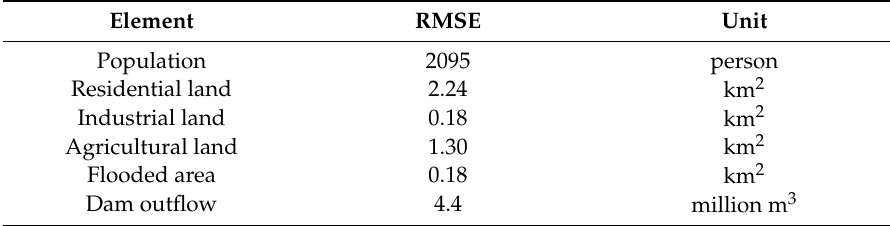
Table 4. Calibration error root mean square error (RMSE).